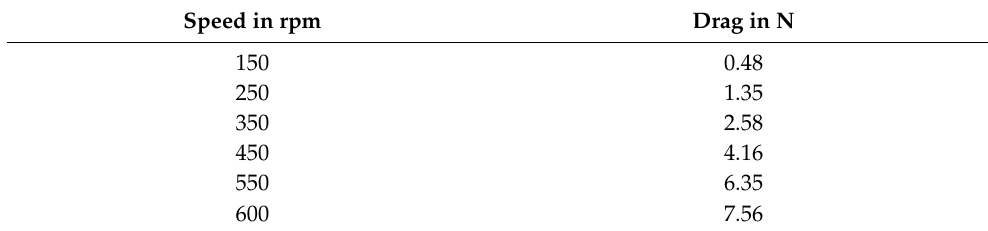
Table 16. Drag for various speeds.